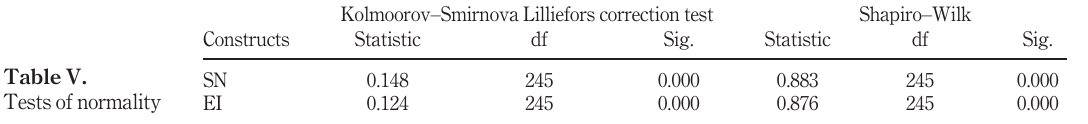
Table IV. Cronbach ’ s a coef fi cient and mean